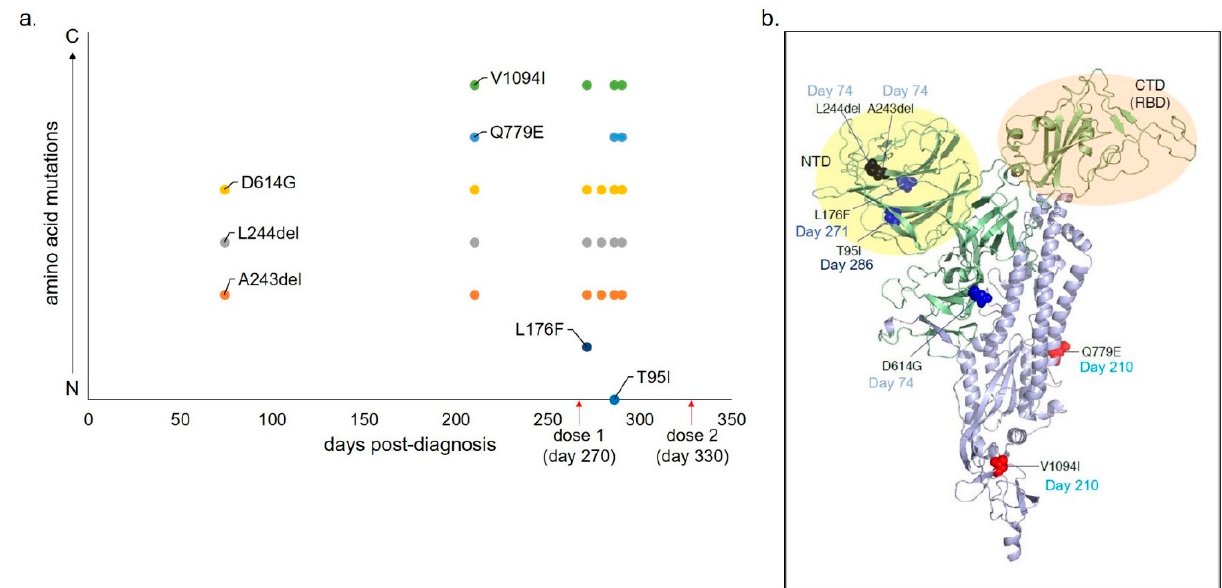
Figure 1. Amino acid mutations detected over time through serial SARS-CoV-2 sequencing during 300 days of virus shedding in patient with B-DEAP (B-cell depletion associated prolonged) COVID-19. ( a ) X-axis indicates days post-diagnosis. Y-axis indicates amino acid mutations detected through the sequencing of nasal swabs positive for SARS-CoV-2 RNA with Ct value < 30, over time. ( b ) Structural representation of mutations over time.